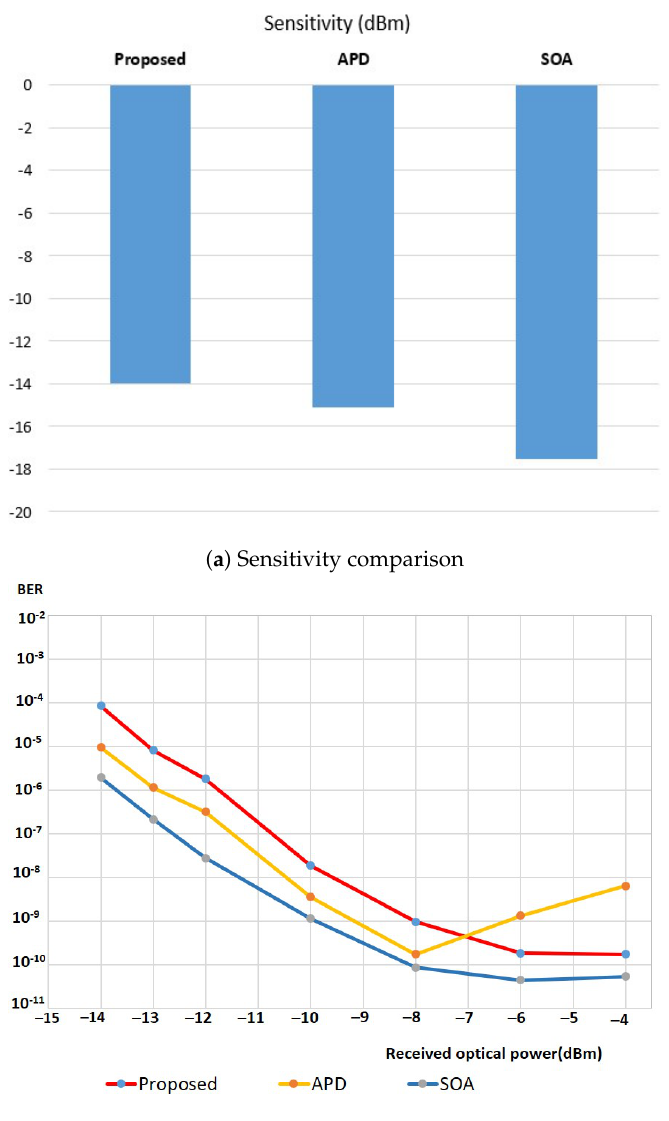
Figure 16. Performance comparison between the proposed method and other methods (avalanche photodiode (APD) used and semiconductor optical amplifier (SOA) + positive intrinsic negative (PIN)